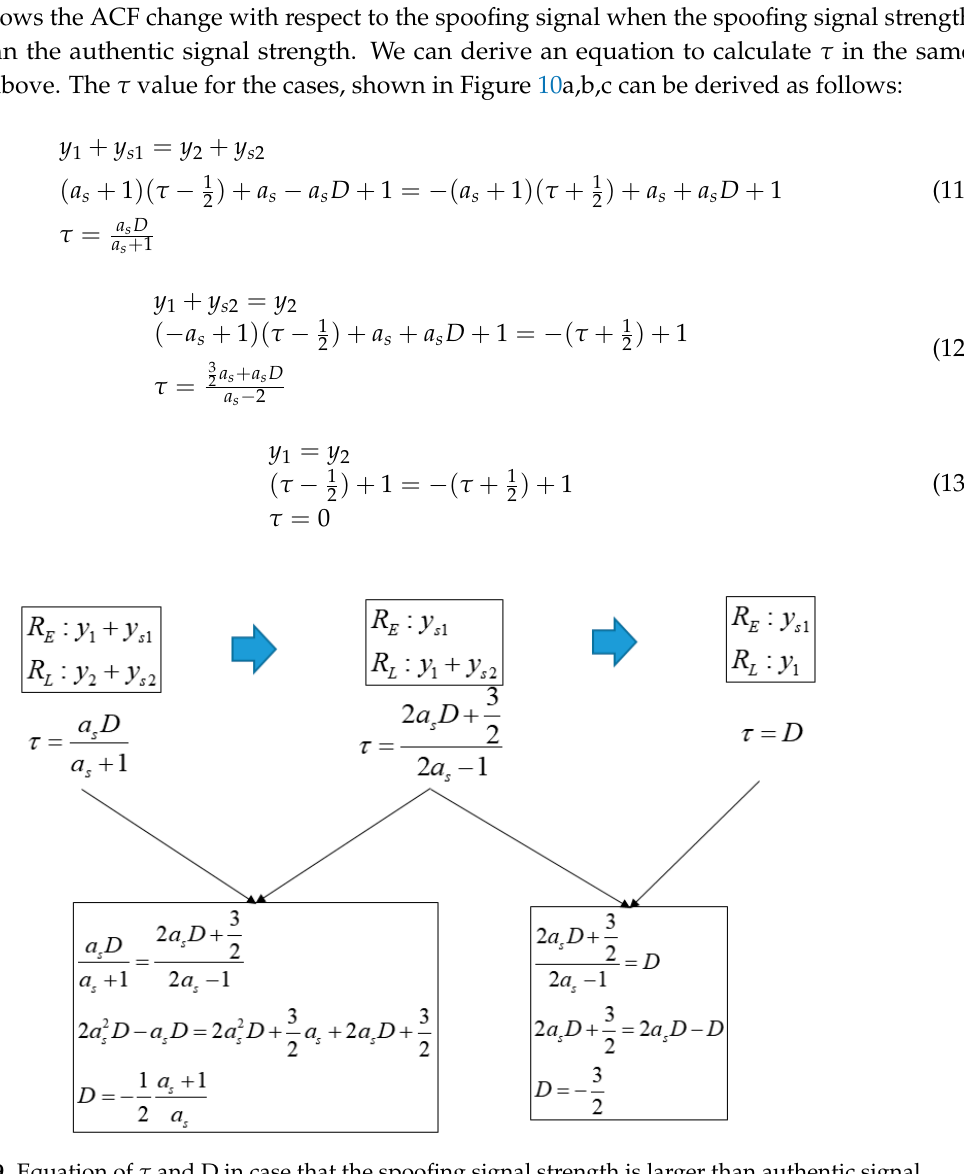
Figure 10. ACF change according to the spoofing signal in case that spoofing signal strength is lower than authentic signal strength. (a)